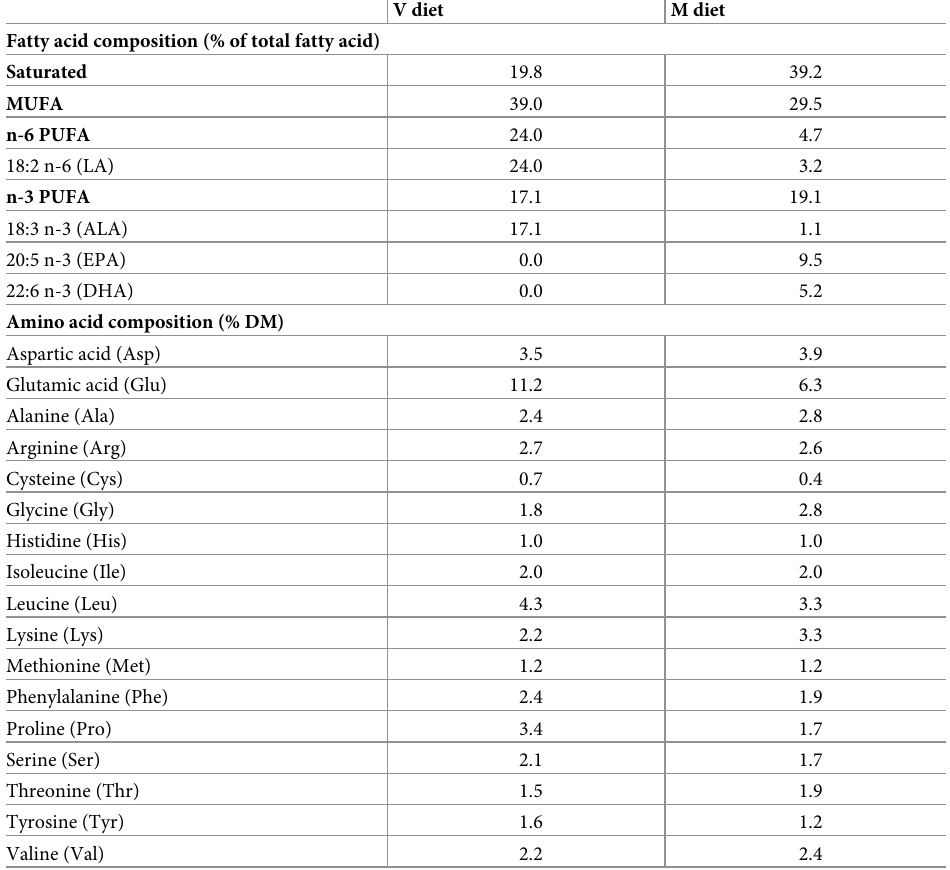
Table 2. Fatty acids and amino acids profiles of the experimental V and M diets (DM: Dry matter). V diet M diet Fatty acid composition (% of total fatty